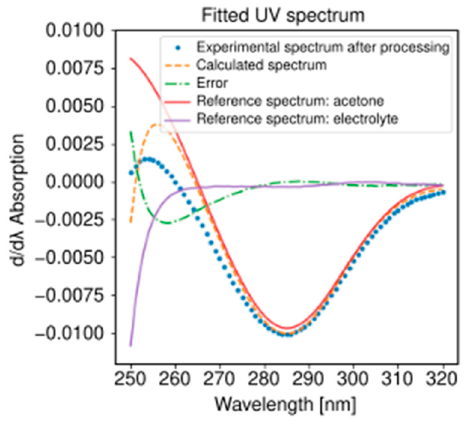
Figure 12. Typical recorded first-derivative spectrum and its deconvolution using reference spectra of acetone and electrolyte.